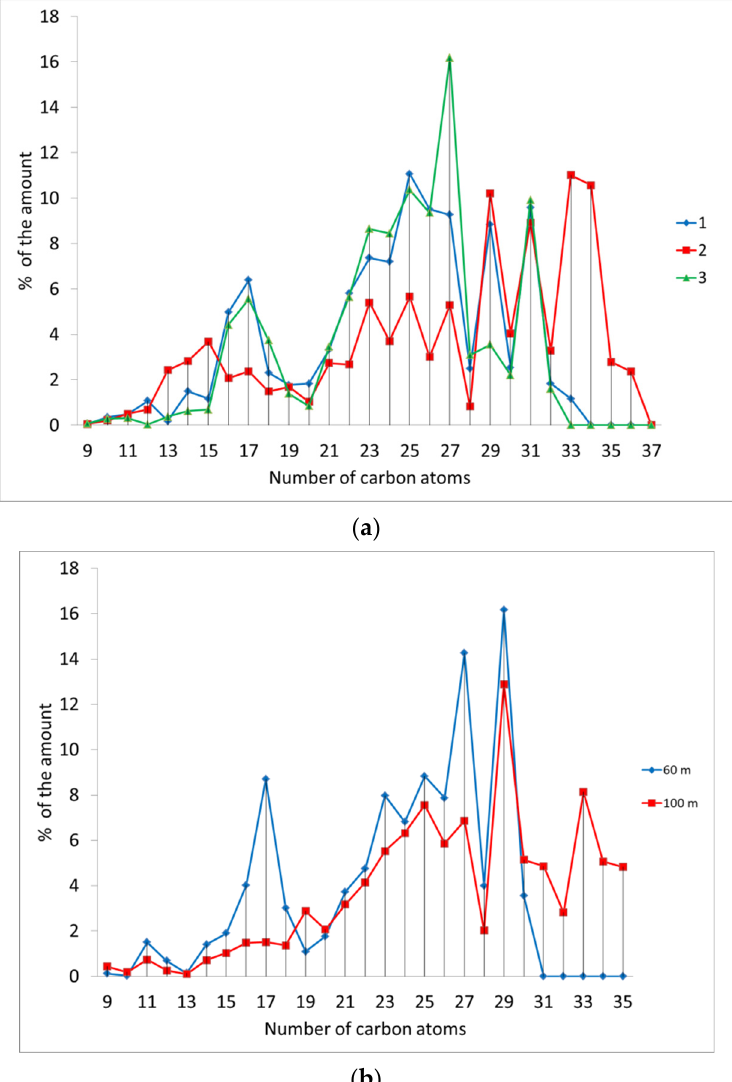
Figure 7. Chromatograms of alkanes in the St. Anna Trough according to the one-year sediment trap ( a ) for different months: 1—October 2018, 2—March 2019, 3—May 2019 and ( b ) for different layers.